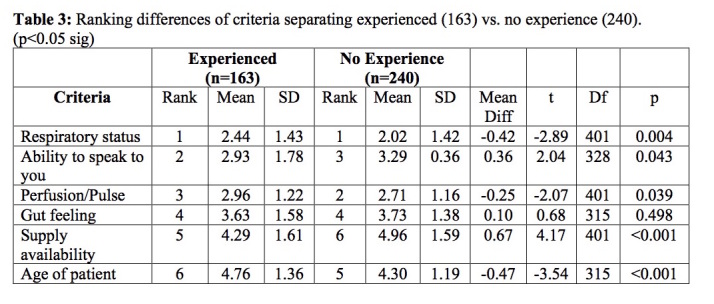

Table 3: Ranking differences of criteria separating experienced, black tag with and without disaster experience (163) vs. no disaster experience (240). (p<0.05 sig)